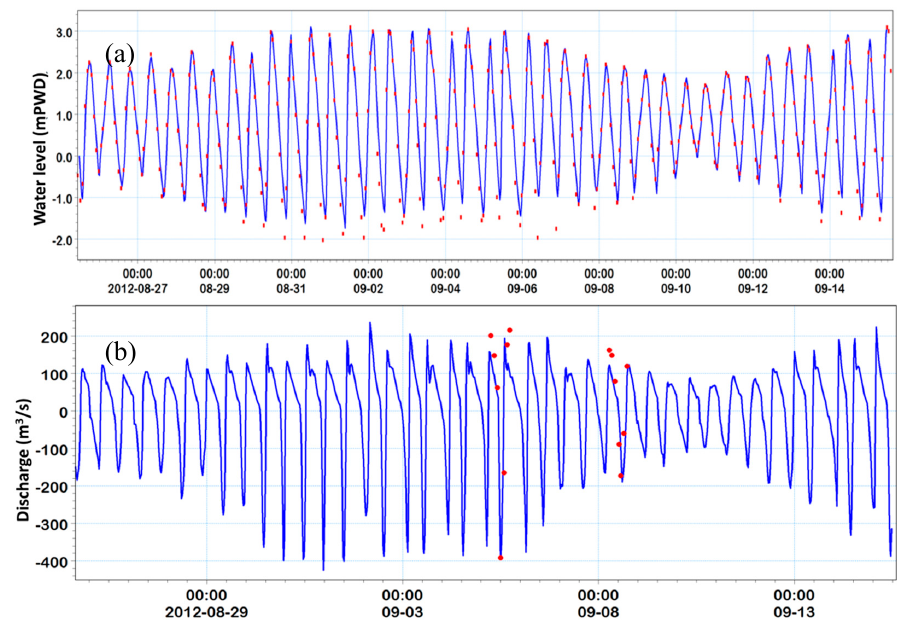
Figure 3. Model calibration: simulated and measured tidal water level ( a ) and discharge ( b ) at Noapara in the Betna River. The lines and dots represent the modelled values and measured values, respectively. The negative discharge values mean that during flood tide the flow is from the opposite direction.